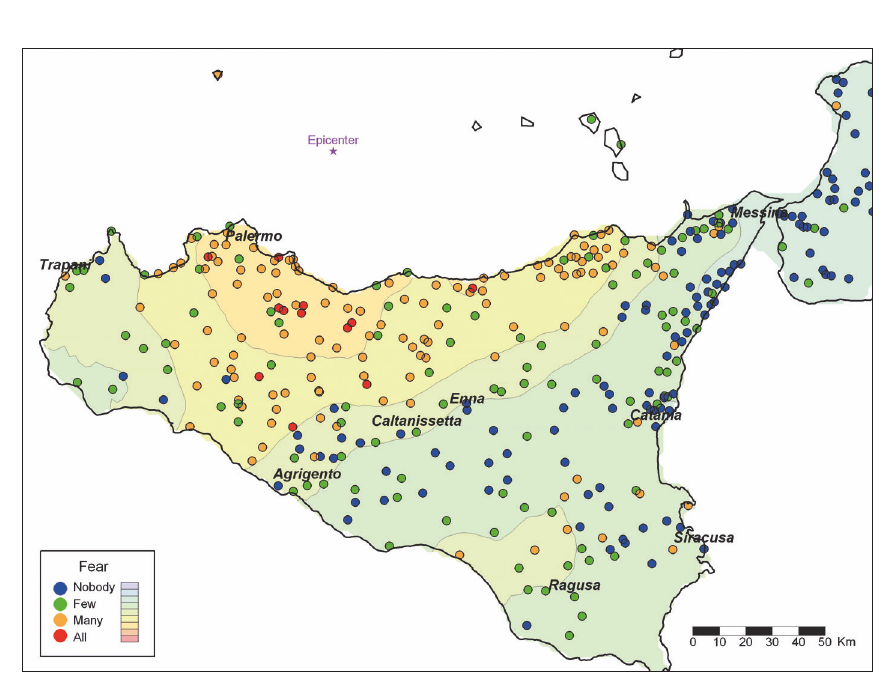
Fig. 4. Fear felt by people during the event with its interpolated and smoothed spatial reconstruction: compare these results with the macroseismic intensity field (fig.